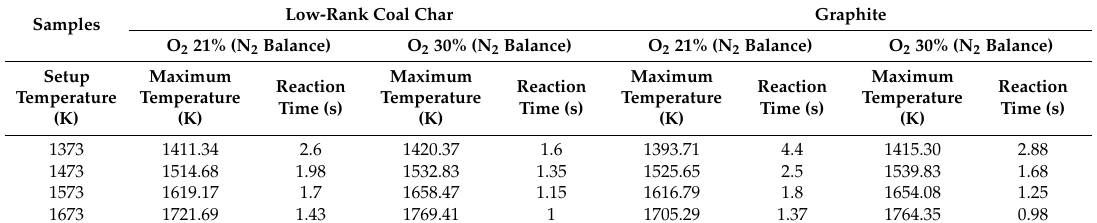
Table 2. Combustion temperatures and reaction time variations for oxygen-enriched